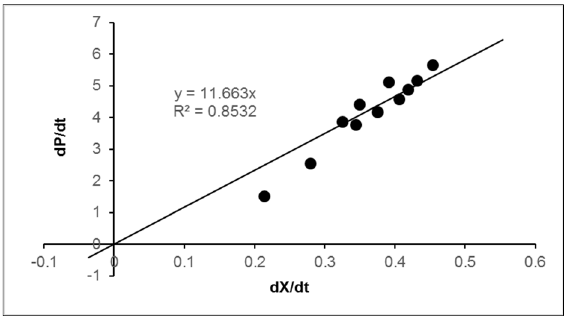
Figure 4 . Relationship in between lipase formation rate and growth rate of E. coli based on the growth-